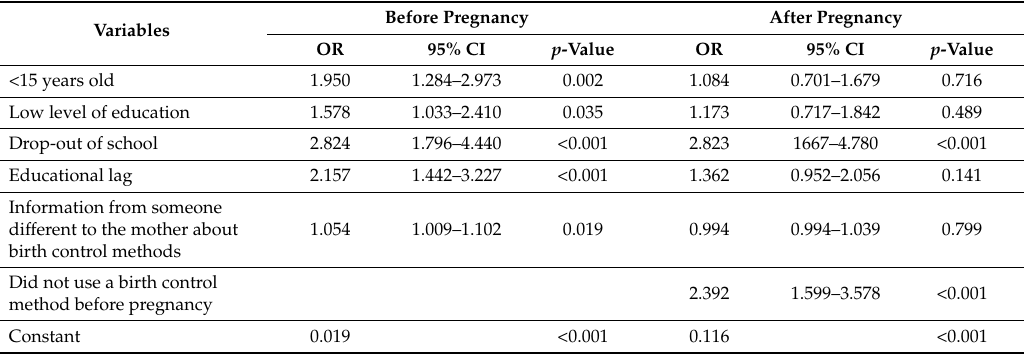
Figure 2. The use of birth control methods before and after pregnancy in a sample of pregnant adolescents. Table 4. Variables associated with the lack of use of birth control methods before and after